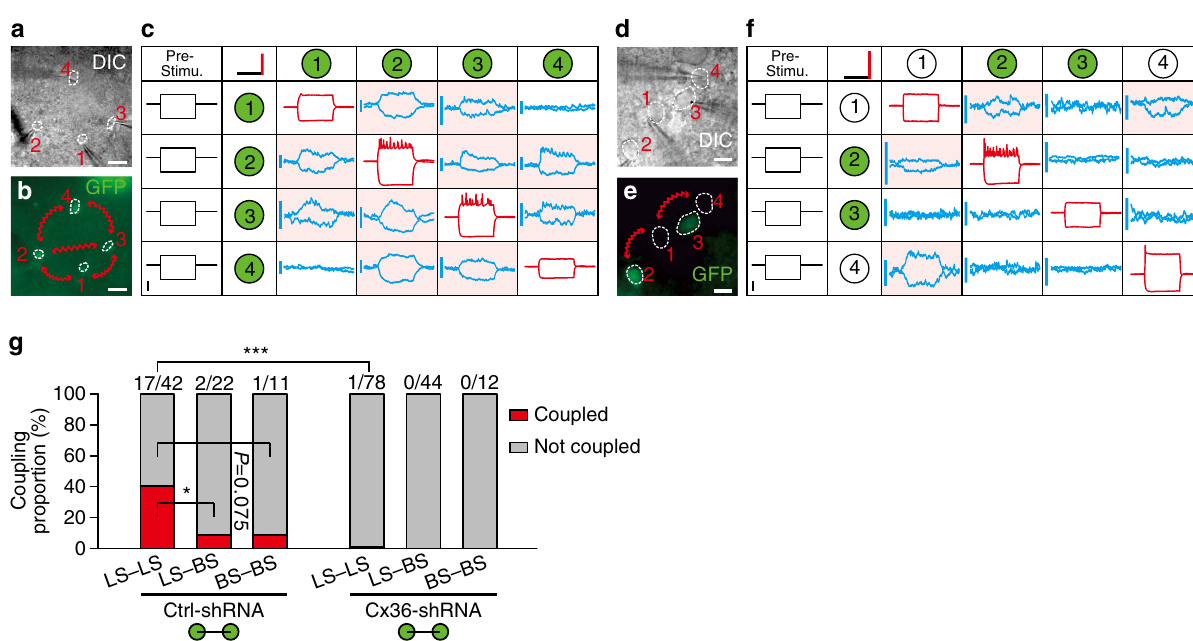
Figure 7 | Connexin 36 is required for formation of electrical coupling between interneurons in neocortical layer 1. ( a , b , d , e ) DIC ( a , d ) and GFP expression ( b , e ) images of a quadruple recording of four layer 1 interneurons in a Ctrl-shRNA ( a , b ) and Cx36-shRNA ( d , e ) neocortical slice. The red arrows indicate reciprocal electrical coupling ( b , e ). Scale bar, 20 m m ( a , b ), 40 m m ( d , e ). ( c , f ) Sample traces of voltage changes in the four neurons in response to sequential current injection into one of the four neurons in Ctrl-shRNA slices ( c ) and Cx36-shRNA slices ( f ). Green circles indicate GFP þ cells, and white circles indicate GFP-negative (GFP (cid:2) ) cells. The average traces are shown in individual table cells at varying scales. Scale bar, 3mV (blue), 70mV (red), 200ms (horizontal, black) and 200pA (vertical, black). ‘Pre-Stimu.’, presynaptic stimulus protocol. ( g ) Summary of the proportion of electrical coupling observed between layer 1 GFP þ interneurons in Ctrl-shRNA or Cx36-shRNA slices at P9–P25. Green circles indicate GFP þ cells. n ¼ 21 mice for Ctrl-shRNA group, 37 mice for Cx36-shRNA group. *** P o 0.001, w 2 -test, Fisher’s exact